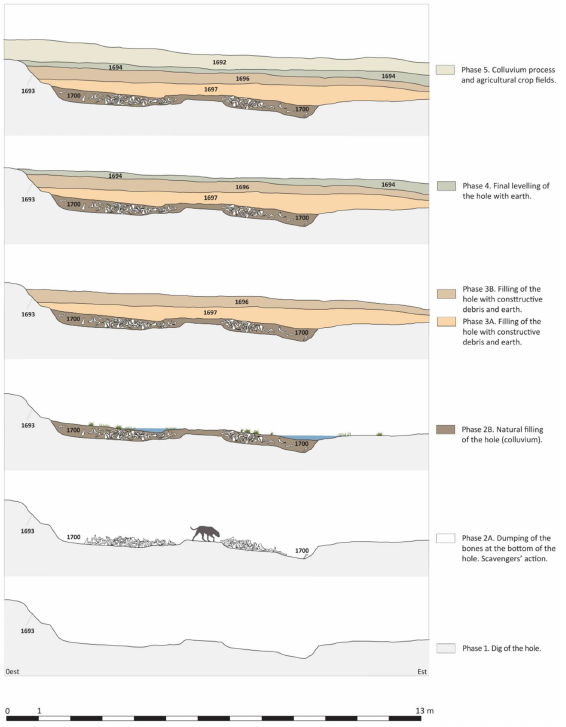
Figure 4. Section of the pit showing how the different stratigraphic units were formed.